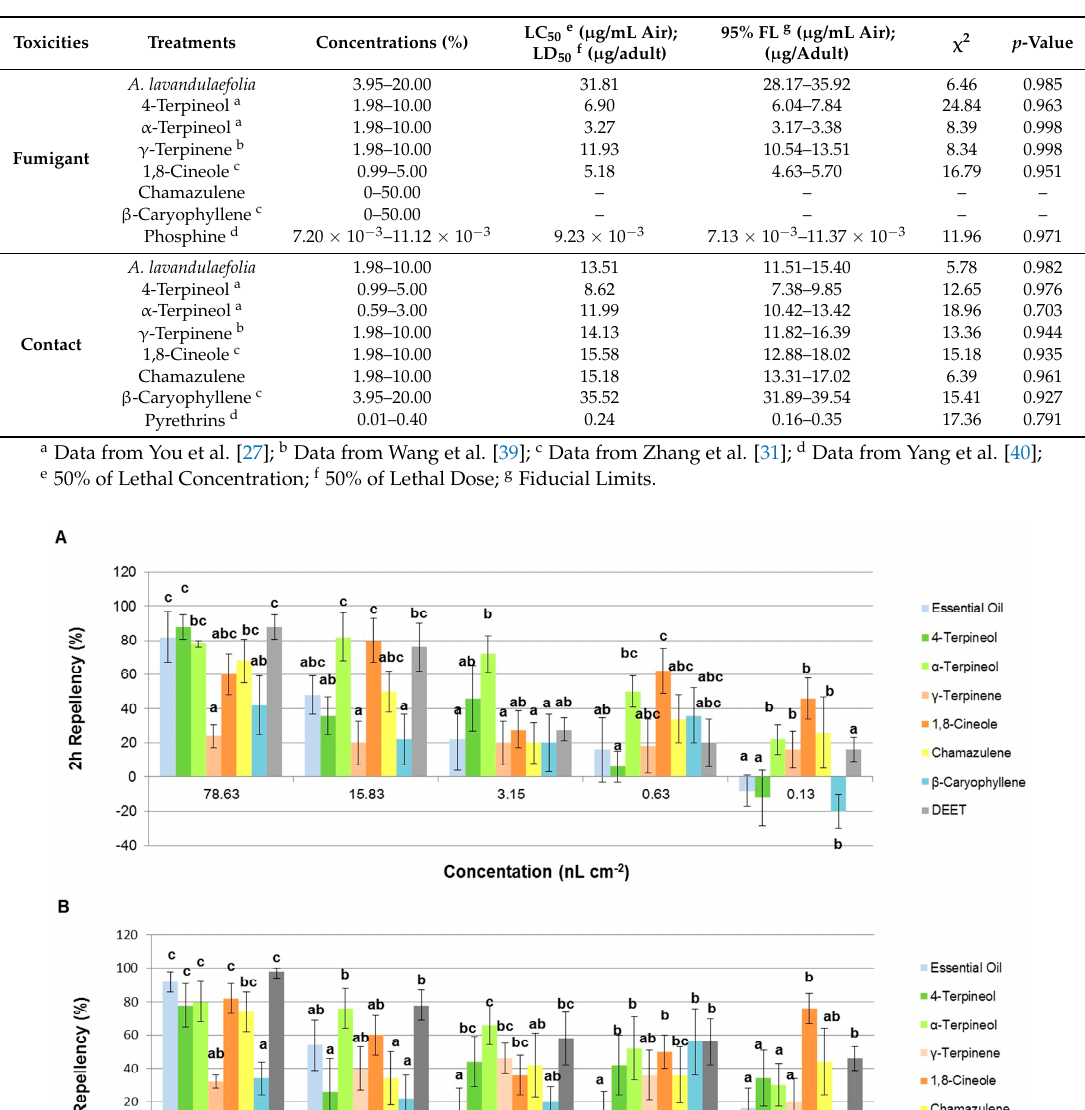
Table 2. Results of insecticidal effects of essential oil and its main components against L. serricorne adults.